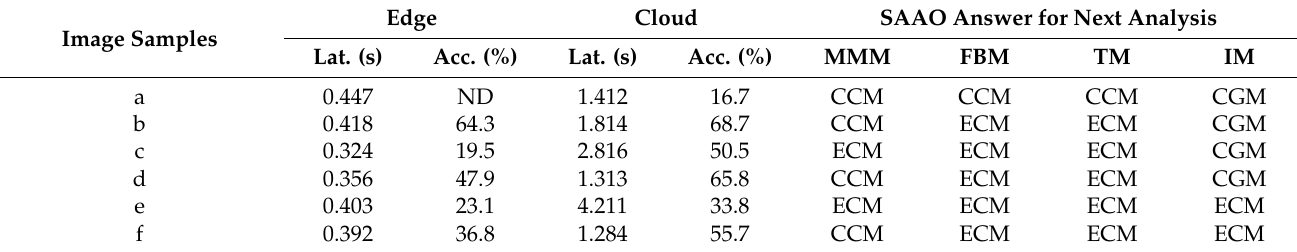
Table 4. Experimental SAAO